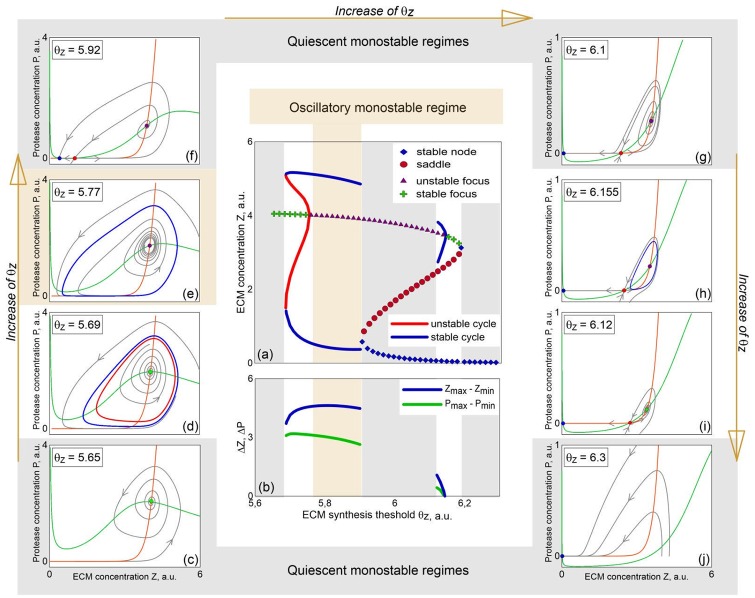
(a) Bifurcation diagram of the system (4)–(7) for varied ECM production threshold value θZ. (b) Differences ΔZ = Zmax–Zmin and ΔP = Pmax–Pmin as functions of θZ. (c)-(j) Phase portraits of the system for various values of θZ. Other parameters are given in Table 1.